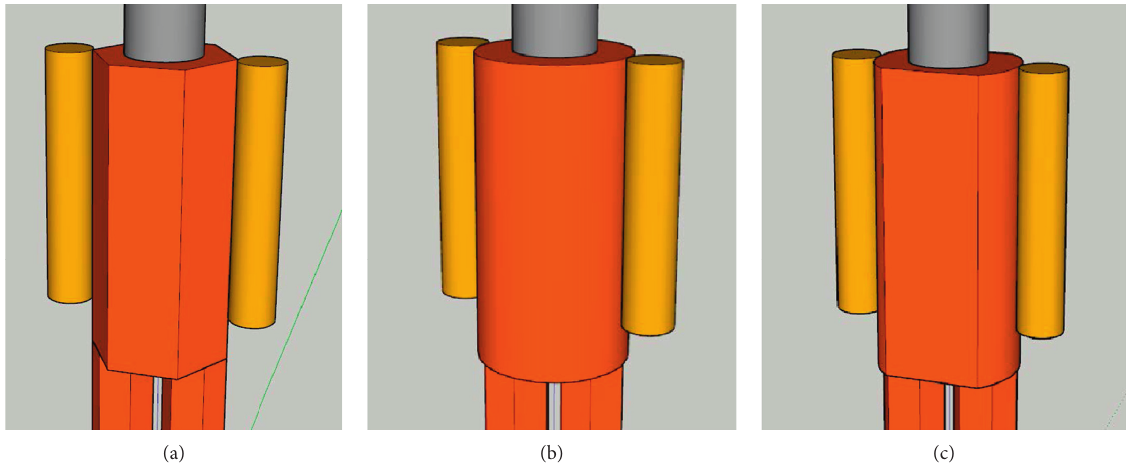
Figure 3: Three optional torso shapes. (a) Prism. (b) Cylinder. (c)